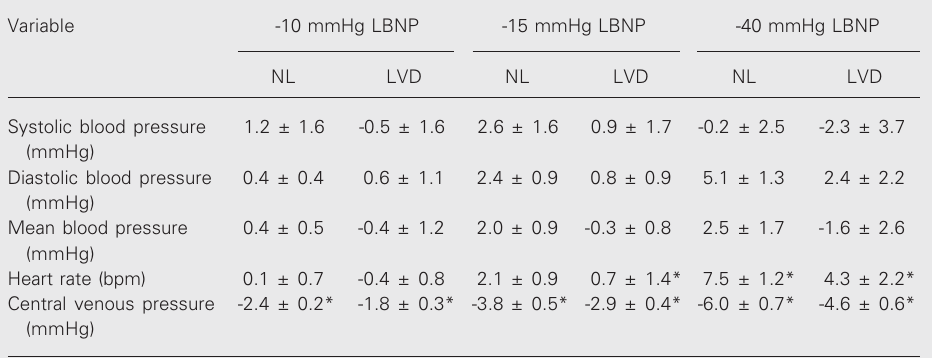
Table 2. Absolute changes in cardiovascular variables during lower body negative